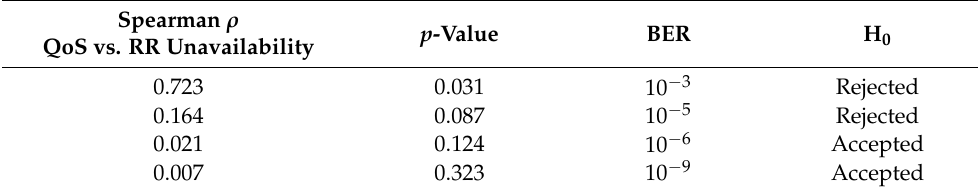
Table 5. Correlation of QoS vs. RR